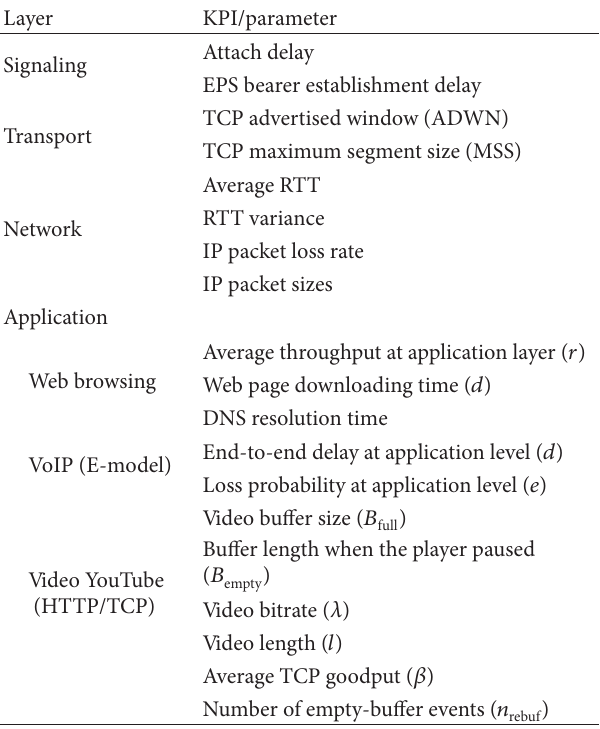
T 2: Summary of KPIs to be measured at each protocol